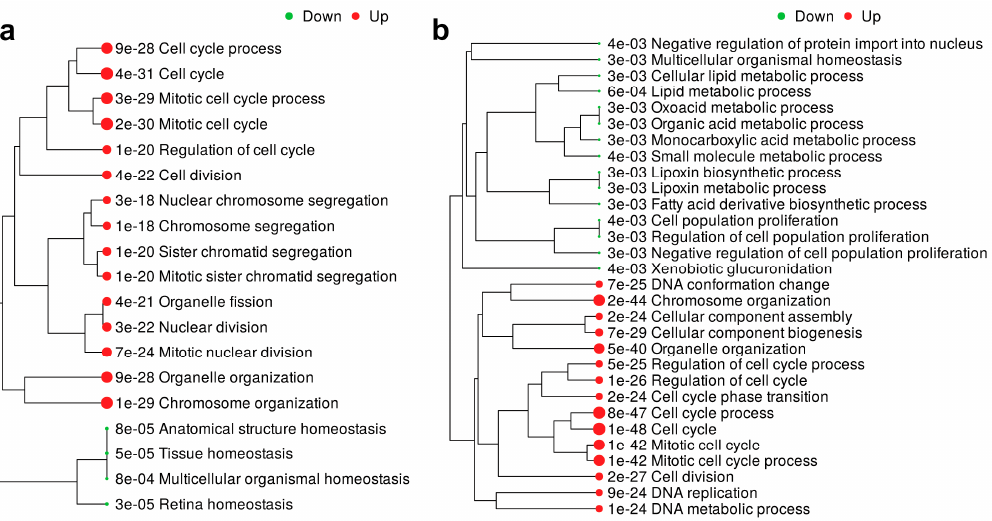
Figure 8. GO enrichment analysis associated with elevated ENO1 and FDPS expression in TNBC. GO enrichment tree in a cohort of 360 TNBC patients divided according to median ENO1 ( a ) and FDPS ( b ) expression. Enrichment p value is indicated for each functional category.